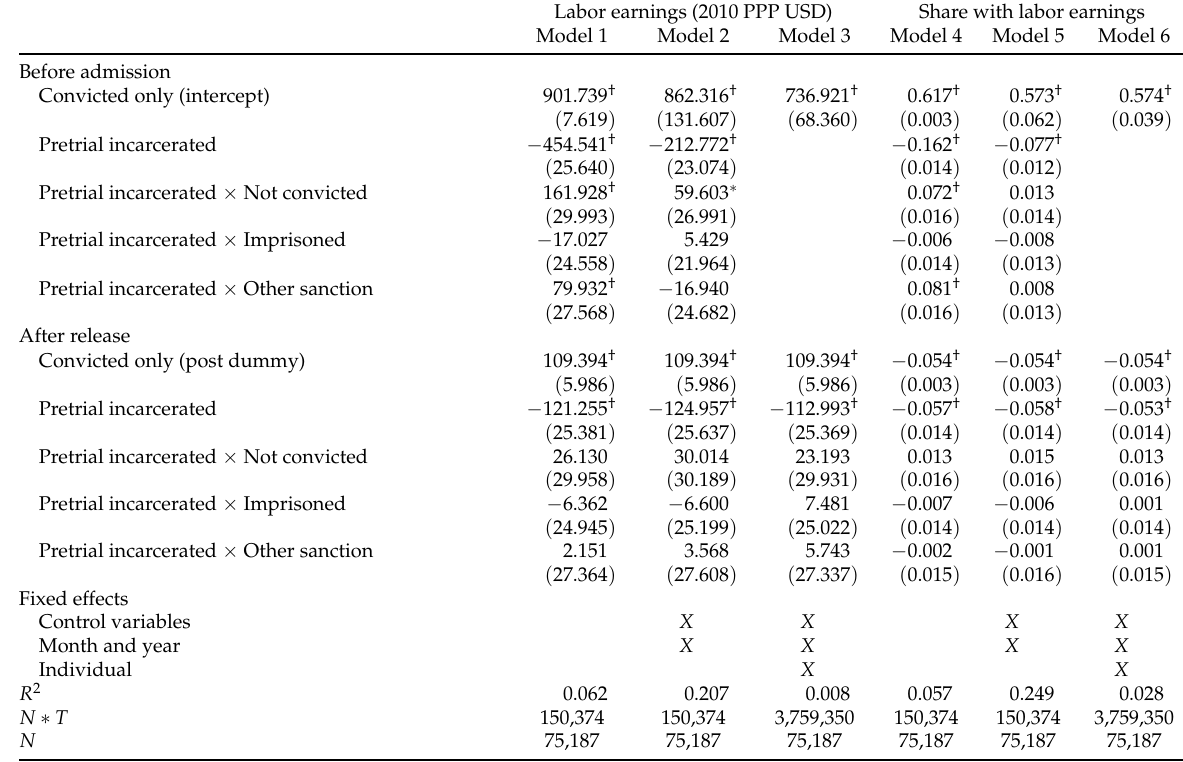
Table 2: Results from estimations of the change in labor market outcomes by pretrial detention